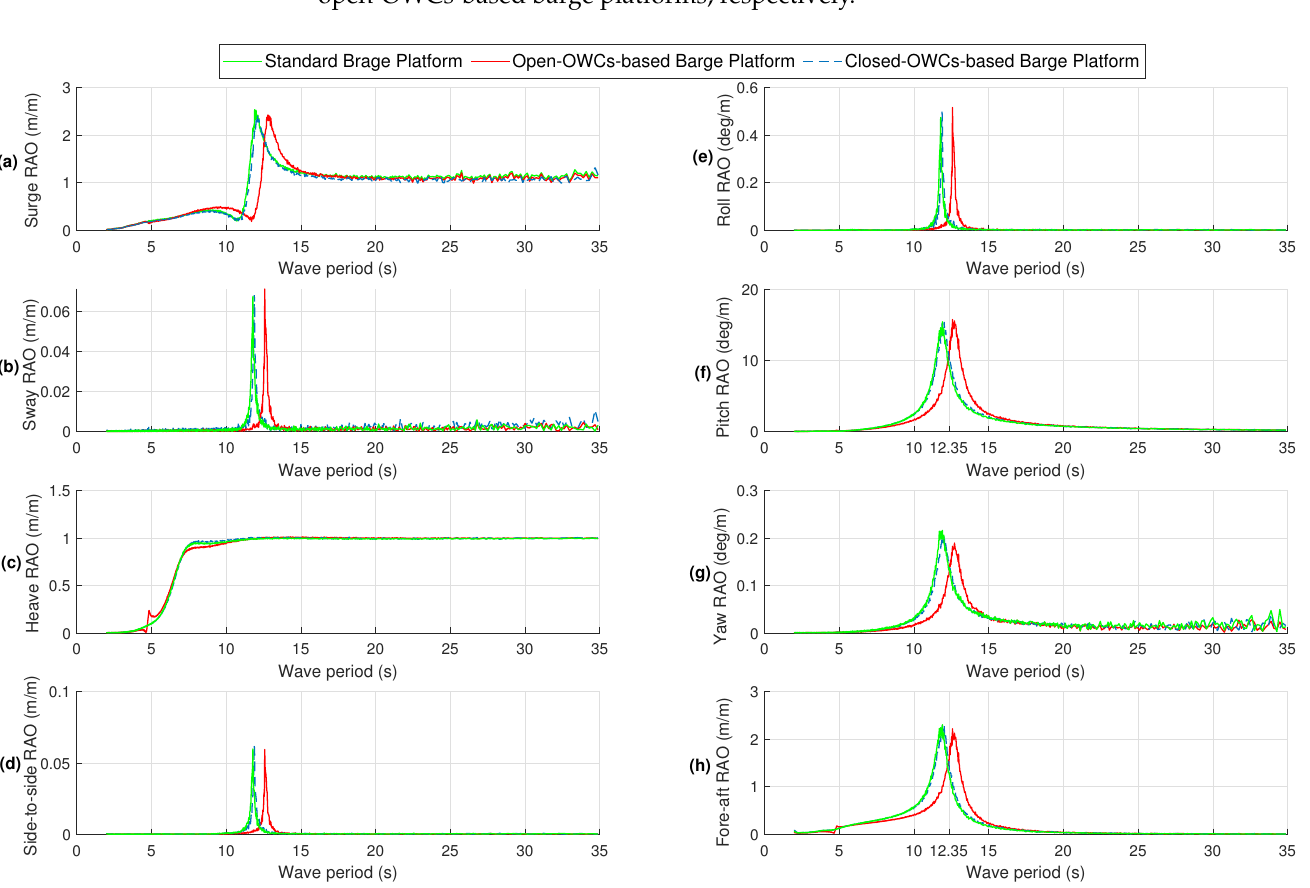
Figure 4. RAOs for ( a ) Surge. ( b ) Sway. ( c ) Heave. ( d ) Side-to-side. ( e ) Roll. ( f ) Pitch. ( g ) Yaw. ( h )